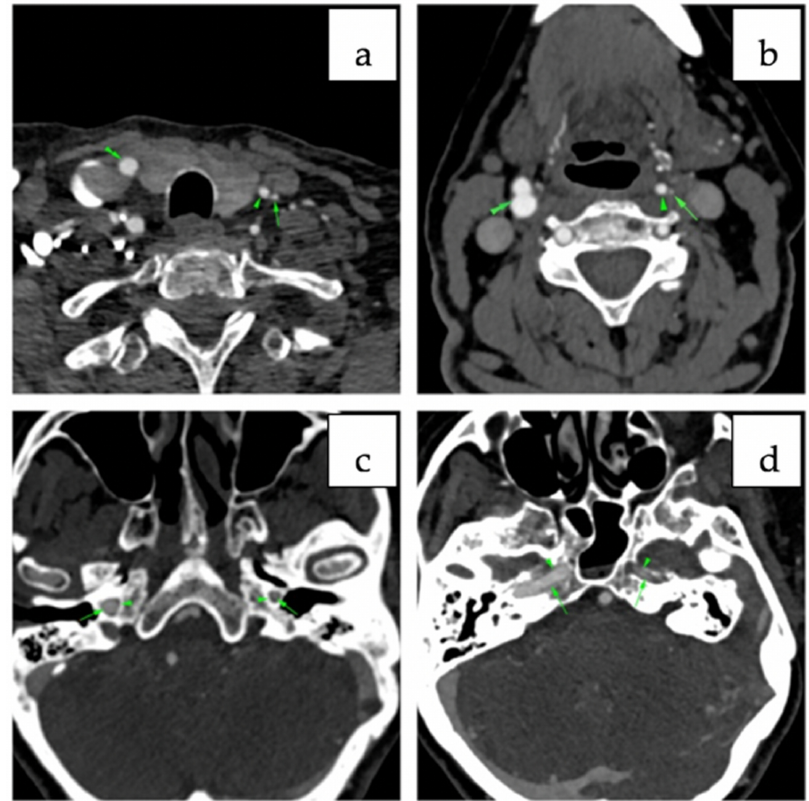
Figure 2. Axial cervical CT angiography: ( a ) in the lower third, near the thyroid—low bifurcation of the left carotid bulb, left ECA with normal lumen (arrowhead) and left ICA with filiform lumen (arrow); right ICA (double arrowhead); ( b ) in the middle third—normal bifurcation of the right carotid bulb (double arrowhead), left ICA with filiform lumen (arrow), left ECA with well-represented, normal lumen (arrowhead); ( c , d ) small diameter of the left carotid canal in the petrous temporal bone compared with the contralateral carotid canal (arrows).